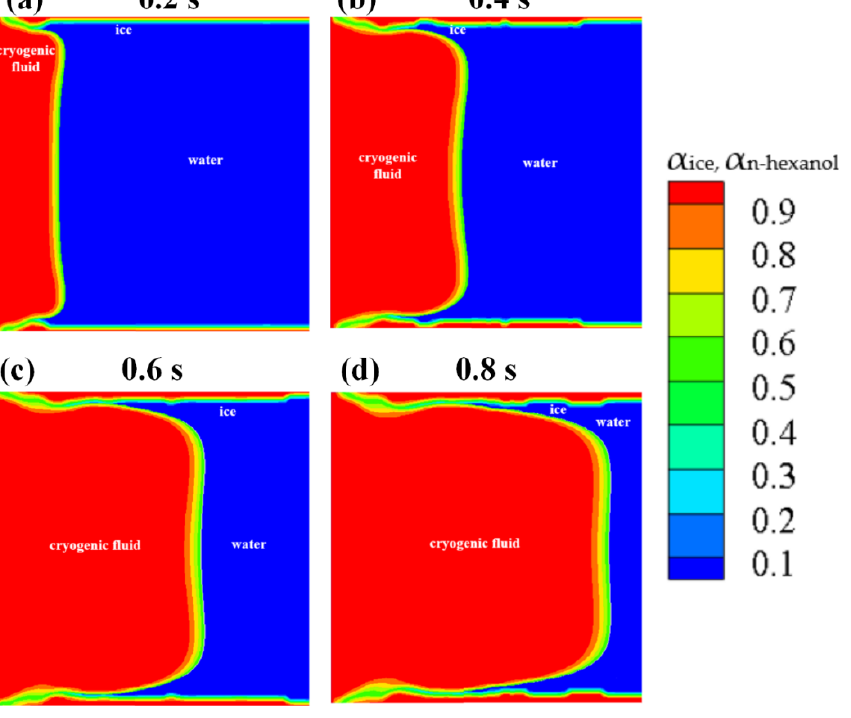
Figure 11. Distributions of cryogenic fluid, water and ice (phase fraction) at various moments ( a ) 0.2 s, ( b ) 0.4 s, ( c ) 0.6 s, and ( d ) 0.8 s.